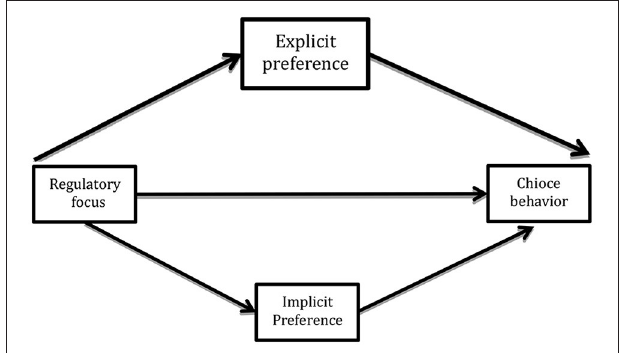
FIGURE 1 | Mediation model as proposed in Hypothesis